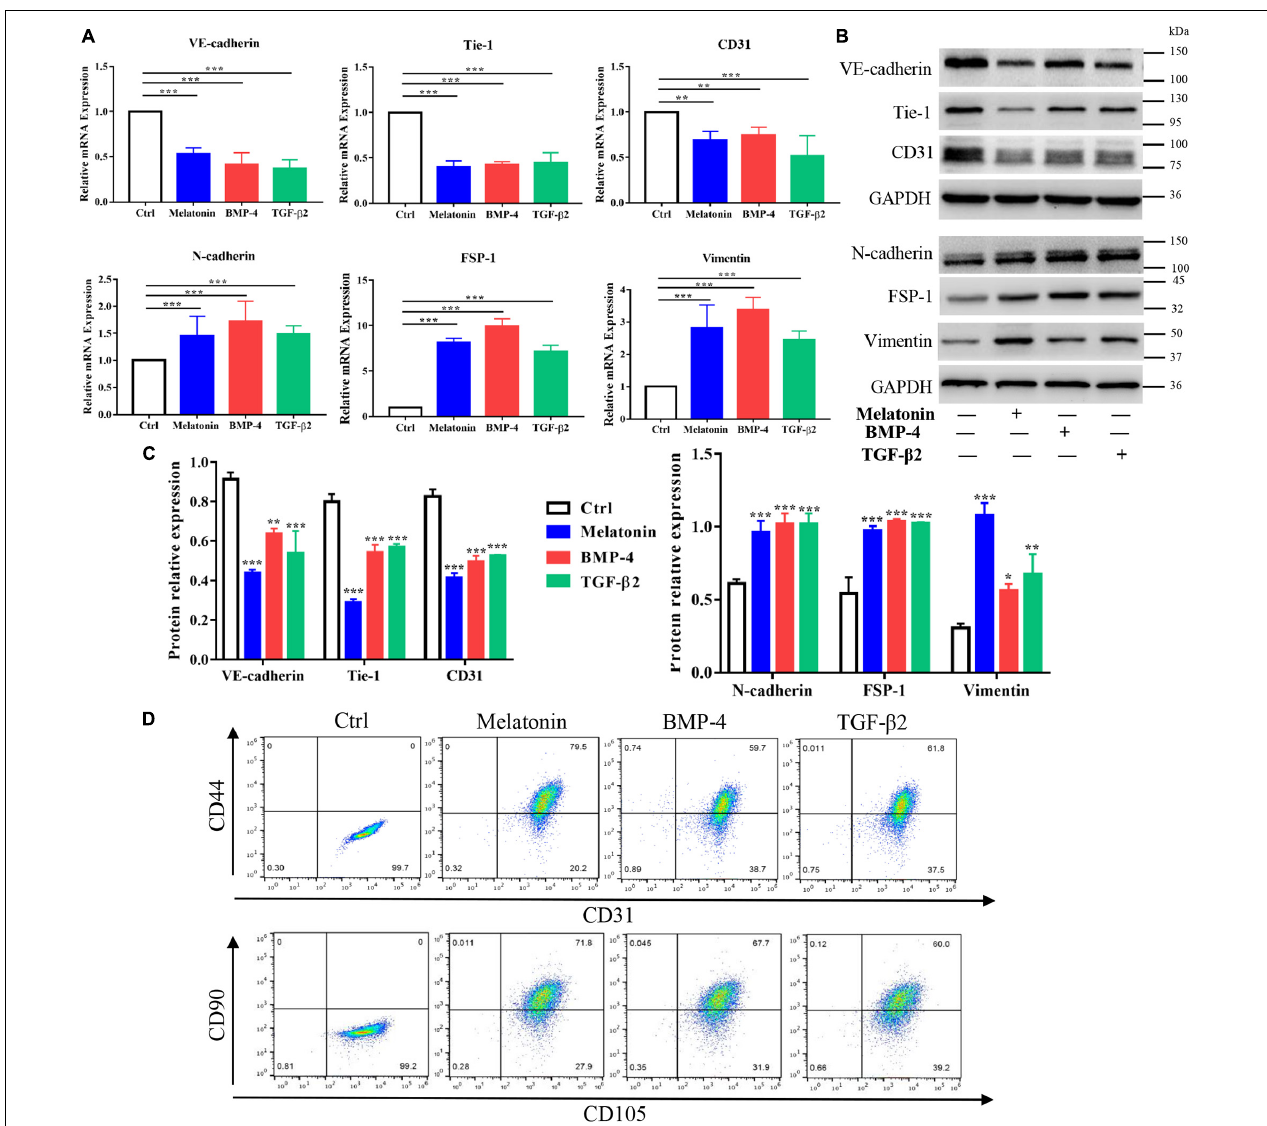
FIGURE 5 | Role of melatonin in EndMT of RAOECs. Primary RAOECs were cultured with melatonin, BMP-4 or TGF- β 2 for 2 weeks. (A) Total RNA was extracted for quantitative RT-PCR. Quantitative RT-PCR showed that melatonin downregulated the expression of the endothelial markers VE-cadherin, Tie-1, and CD31 and upregulated the expression of the mesenchymal markers N-cadherin, FSP-1 and vimentin. (B,C) Protein lysates were extracted for western blot and protein quantification analysis, and the data showed results similar to those of quantitative RT-PCR. (D) Flow cytometry results showed the co-expression of CD31 and CD44 as well as CD105 and CD90 in RAOECs cultured with melatonin, BMP-4 or TGF- β 2. The data represent the mean ± SD. * P < 0.05, ** P < 0.01, *** P < 0.001 versus the control